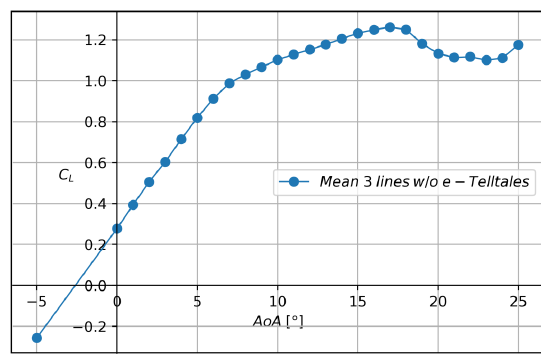
Figure 8. Lift coefficient mean of three